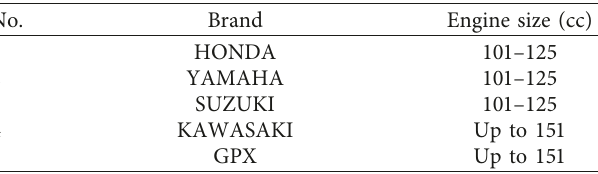
Table 2: Number of registered motorcycles in Thailand.